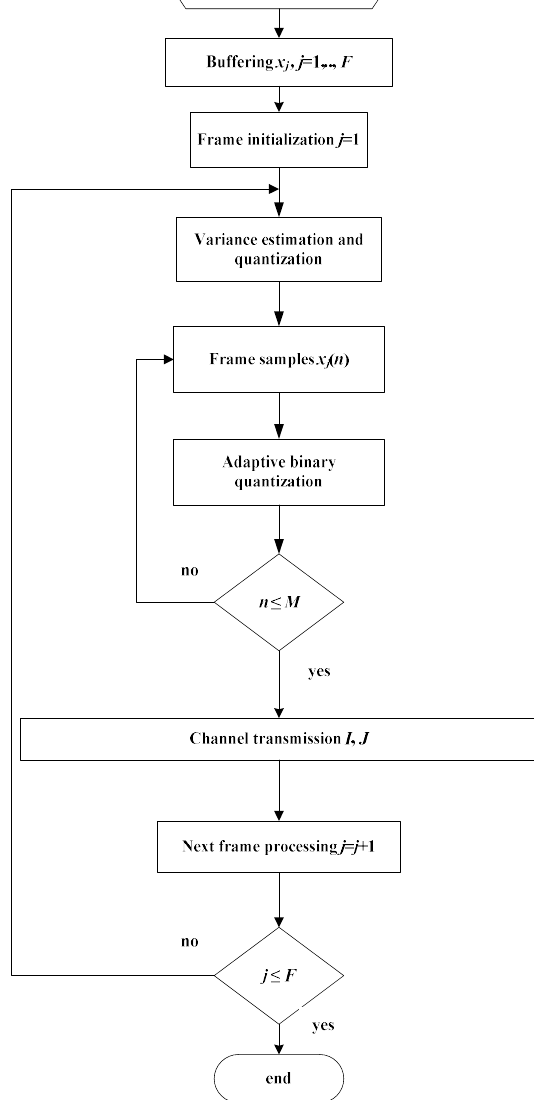
Figure 8. Pulse code modulation algorithm with a binary quantizer.